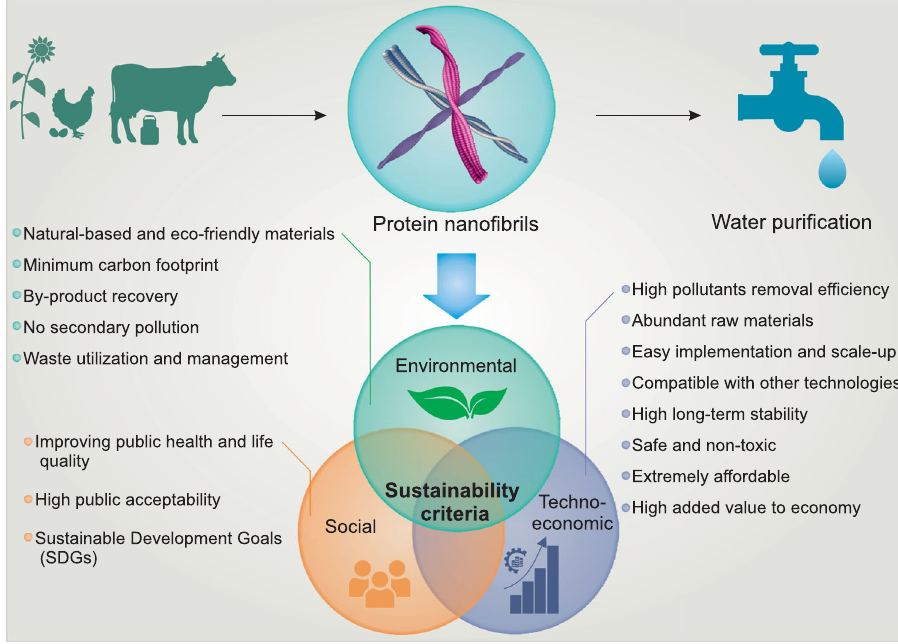
Fig. 4 Sustainability aspects of protein nano fi brils water puri fi cation agents. The main sustainability impacts of using protein nano fi brils for water puri fi cation based on three sustainability pillars of sustainability: Environmental, techno-economic, and